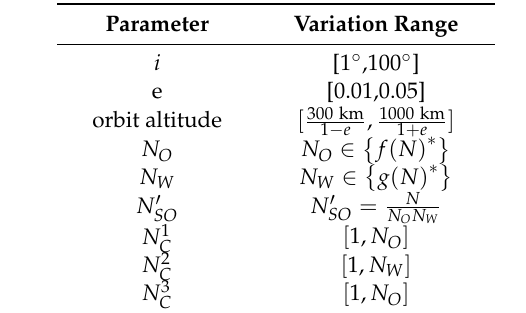
Table 2. The variation range of the parameters defining 3D-LFC composed of N